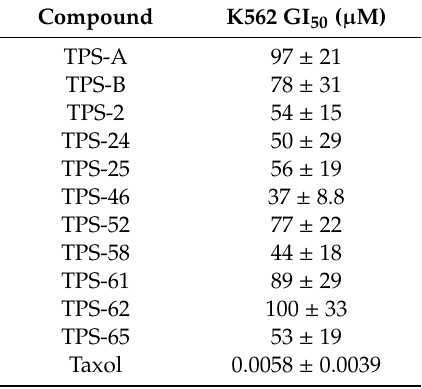
Table 1. Anticancer activity of TPS analogs against human leukemia K562 cells. The averaged GI 50 values with associated standard deviation of compounds from three experimental replicates are shown.